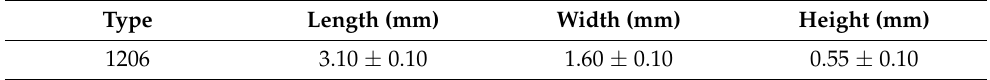
Table 1. Dimensions of the components used [16].